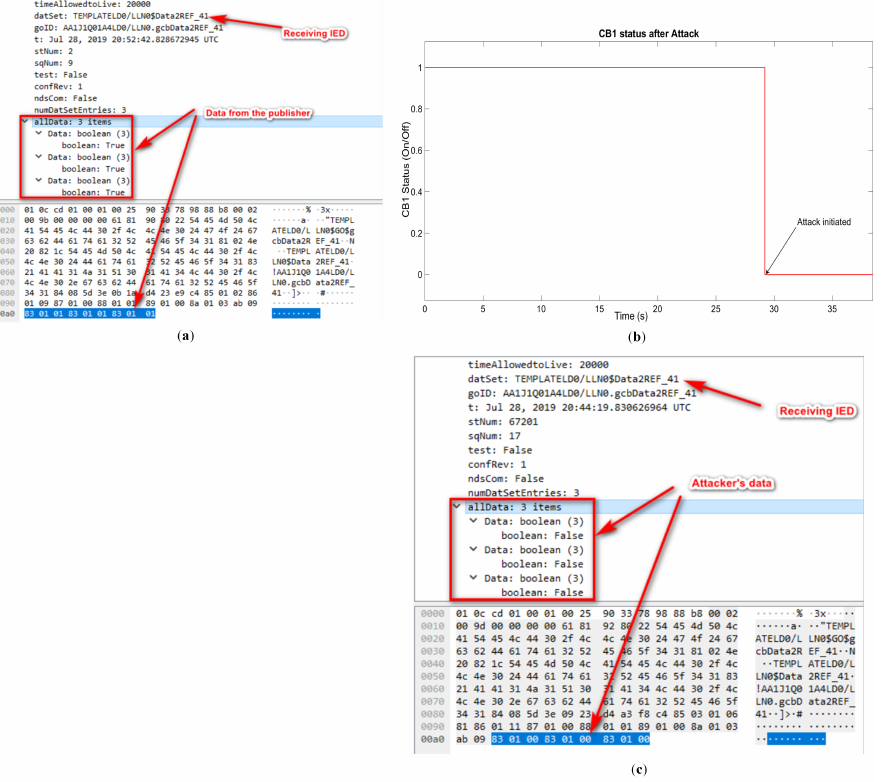
Figure 10. ( a ) GOOSE message captured before attack, ( b ) change in CB1 status and ( c ) GOOSE message captured after